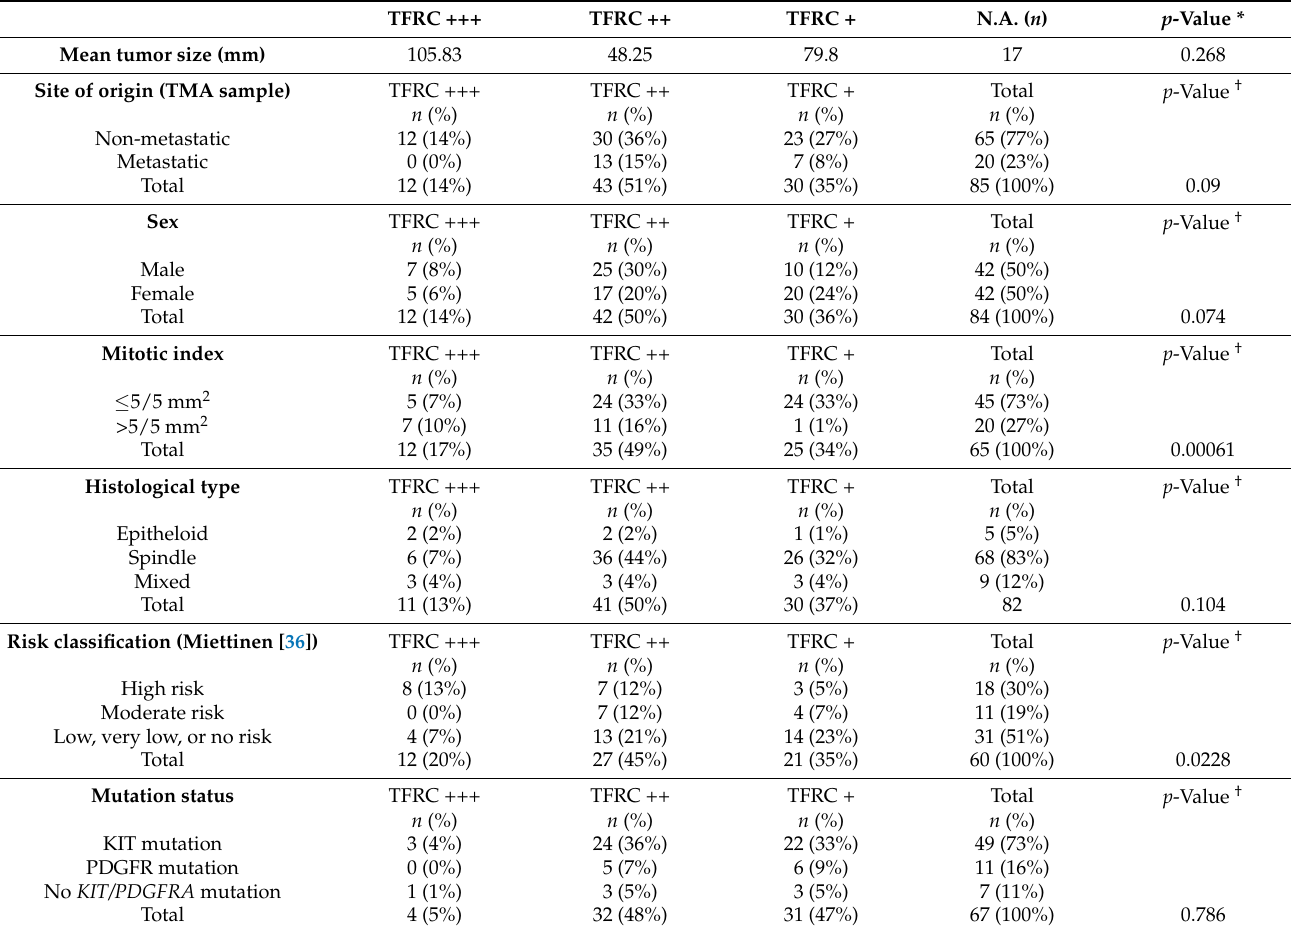
Table 1. The association of TFRC-ir with clinicopathologic characteristics in GIST TMA samples